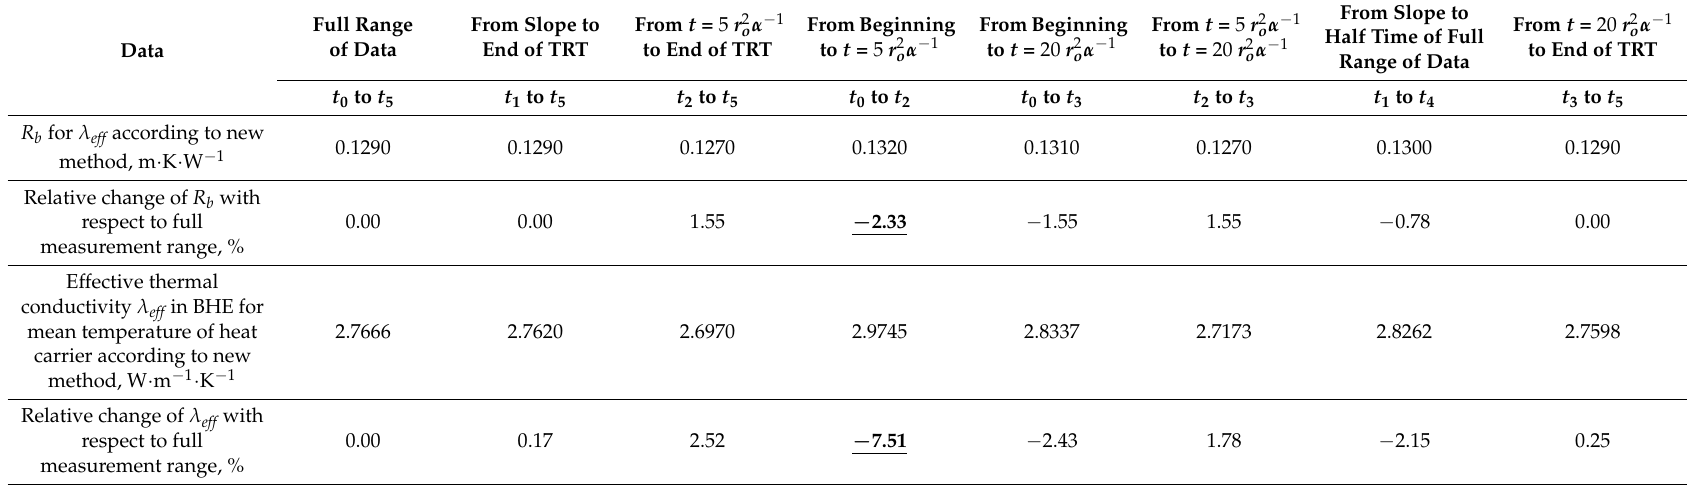
Table 6. BHE thermal resistivity R b and effective thermal conductivity λ eff , determined using the new method for various data intervals (for TRT in ˙Zar ó